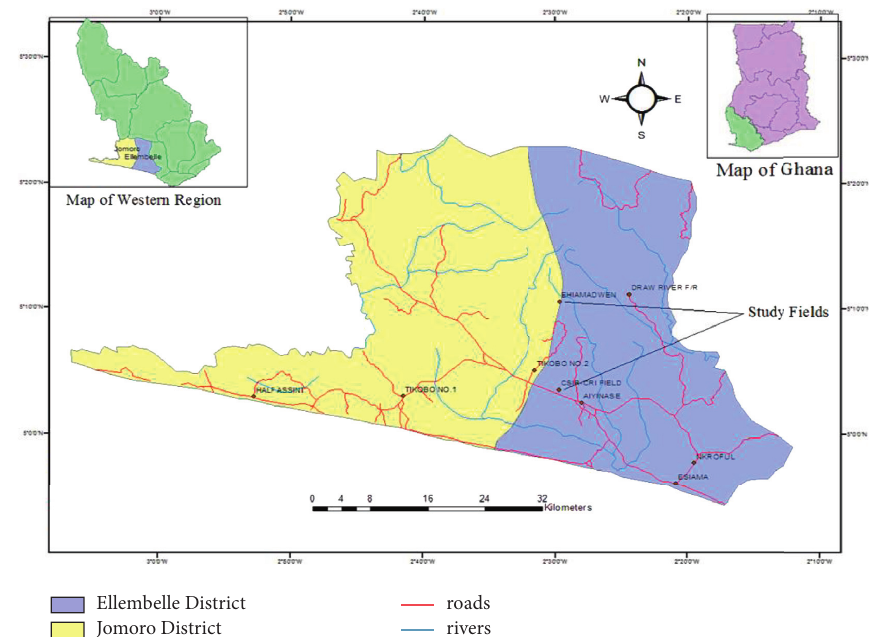
Figure 1: Map of Ellembelle and Jomoro districts showing the research study fields. Source: Ghana districts (2013).